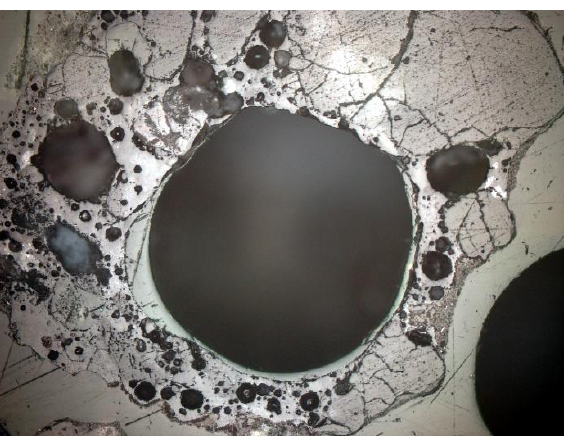
Figure 28. Closed pores visible under a petrographic microscope, polished section, 1P, 100×, re- flected light.